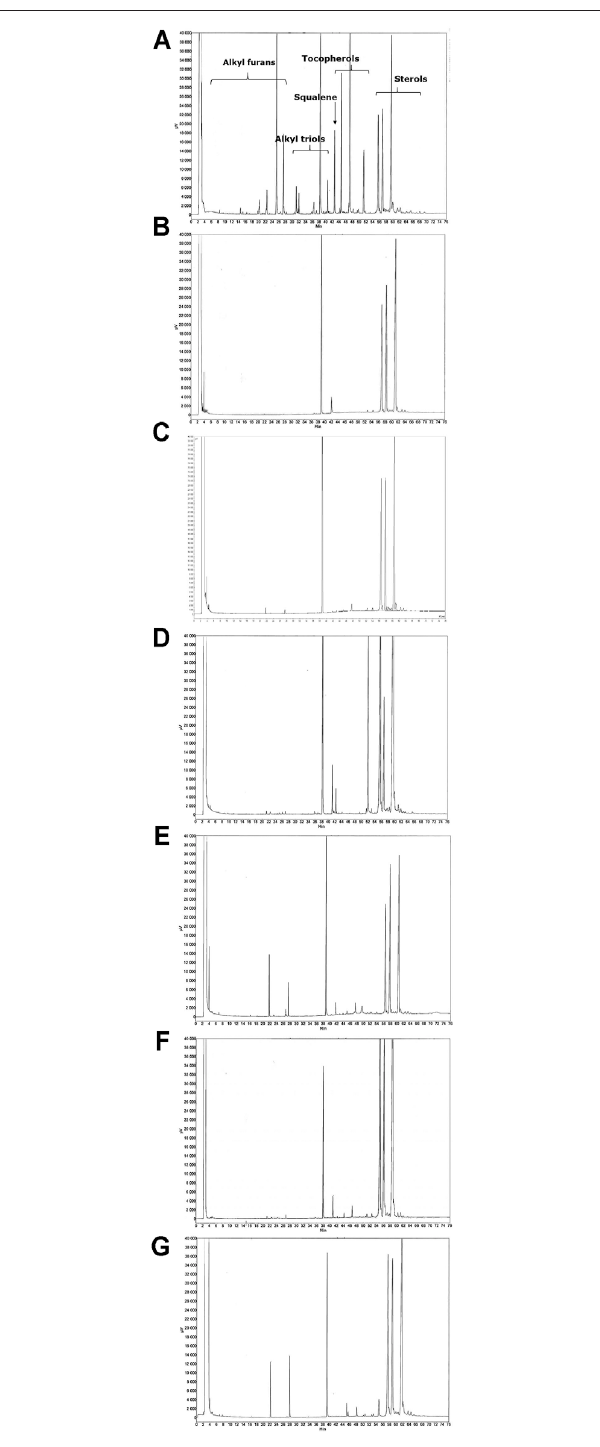
FIGURE 1 | Typical gas chromatography pro fi les of the products. (A) PIASCLEDINE-ExpASU ® ; (B) Saponic; (C) Persemax; (D) Arthocare; (E) Avovida; (F) Insaponi fi able 300; and (G) Arthrocen. For each product, the mass of 20 individual capsules was weighed and recorded. The content of the capsules was collected and subjected to a Soxhlet extraction using chloroform.ThemassoftheSVOCfractionwasdeterminedbygravimetryand